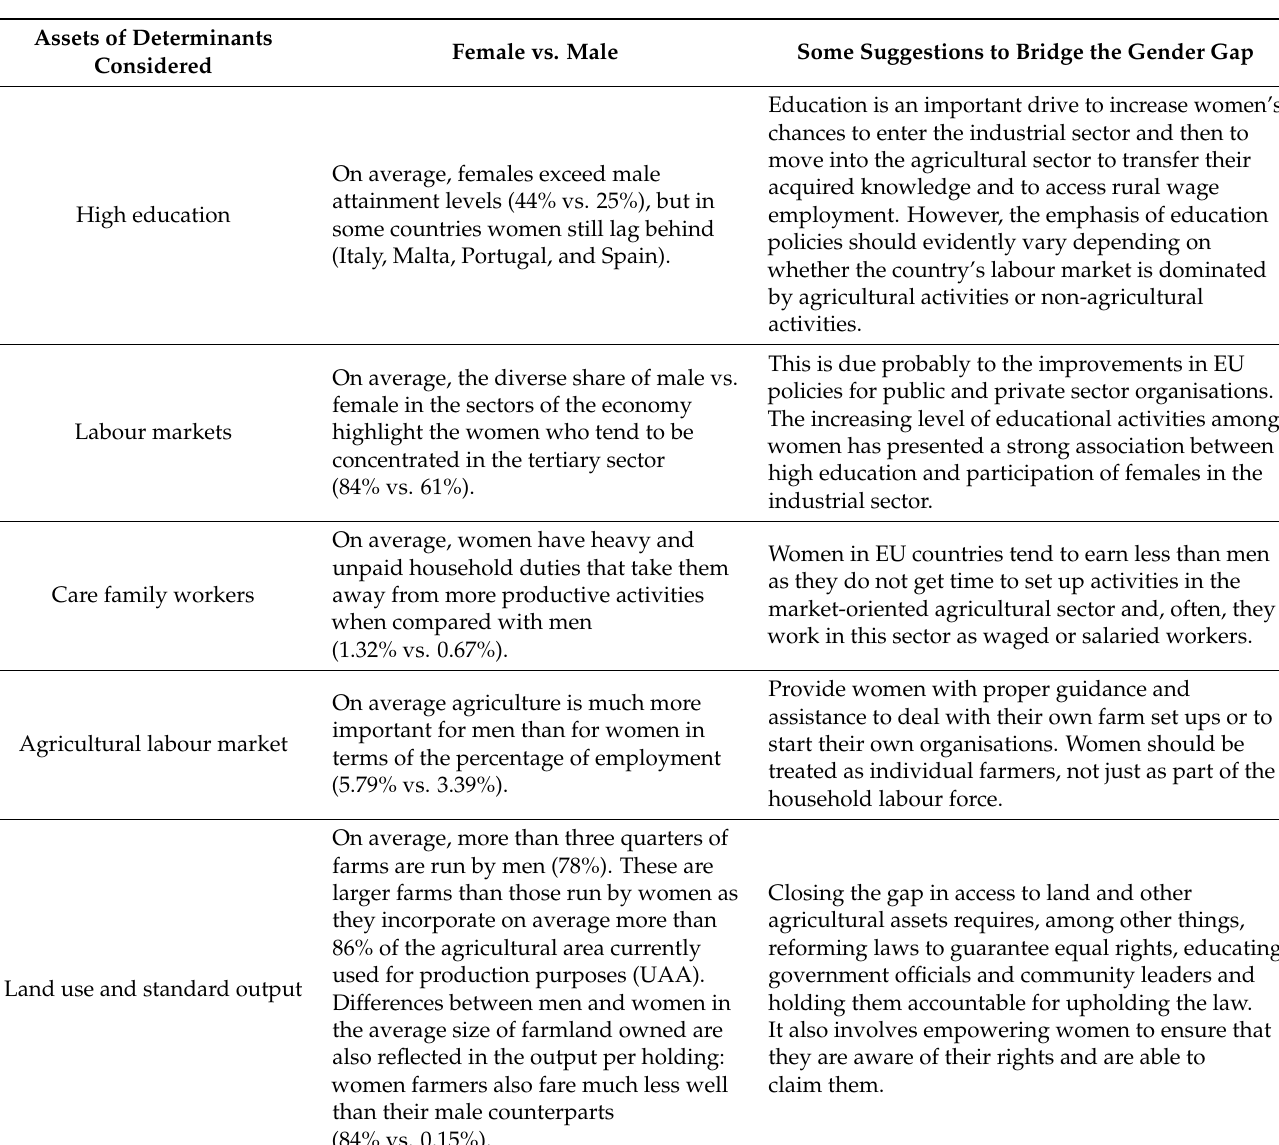
Table 10. How to bridge the gender gap in the EU agricultural sector in relation to assets of determi- nants